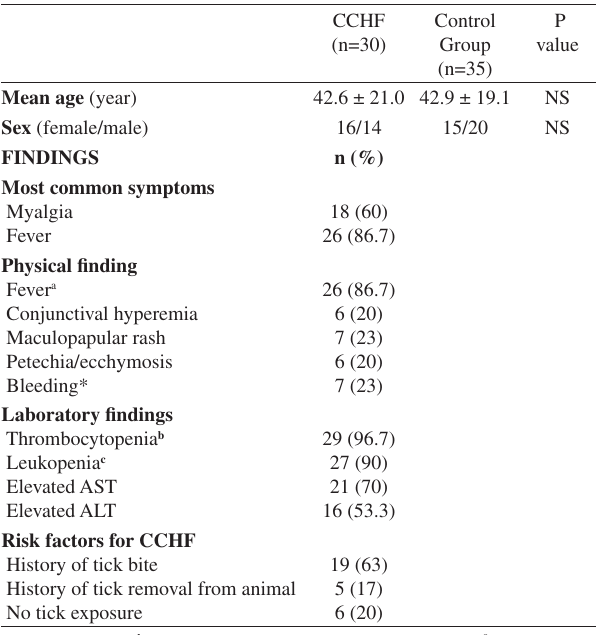
Table 1- Demographic, clinical and laboratory data for patients with Crimean–Congo hemorrhagic fever and the control group.